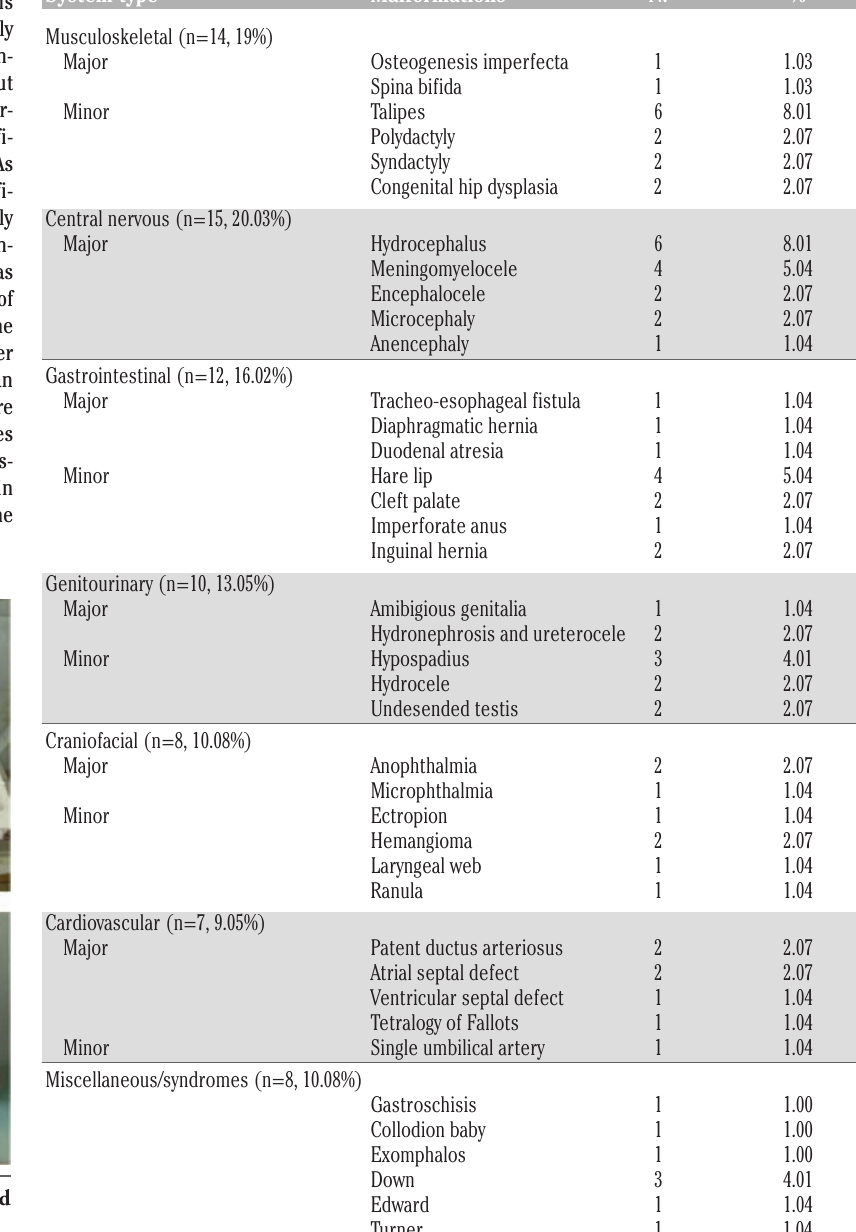
Table 1. Type of congenital malformations observed in patients (n=74).